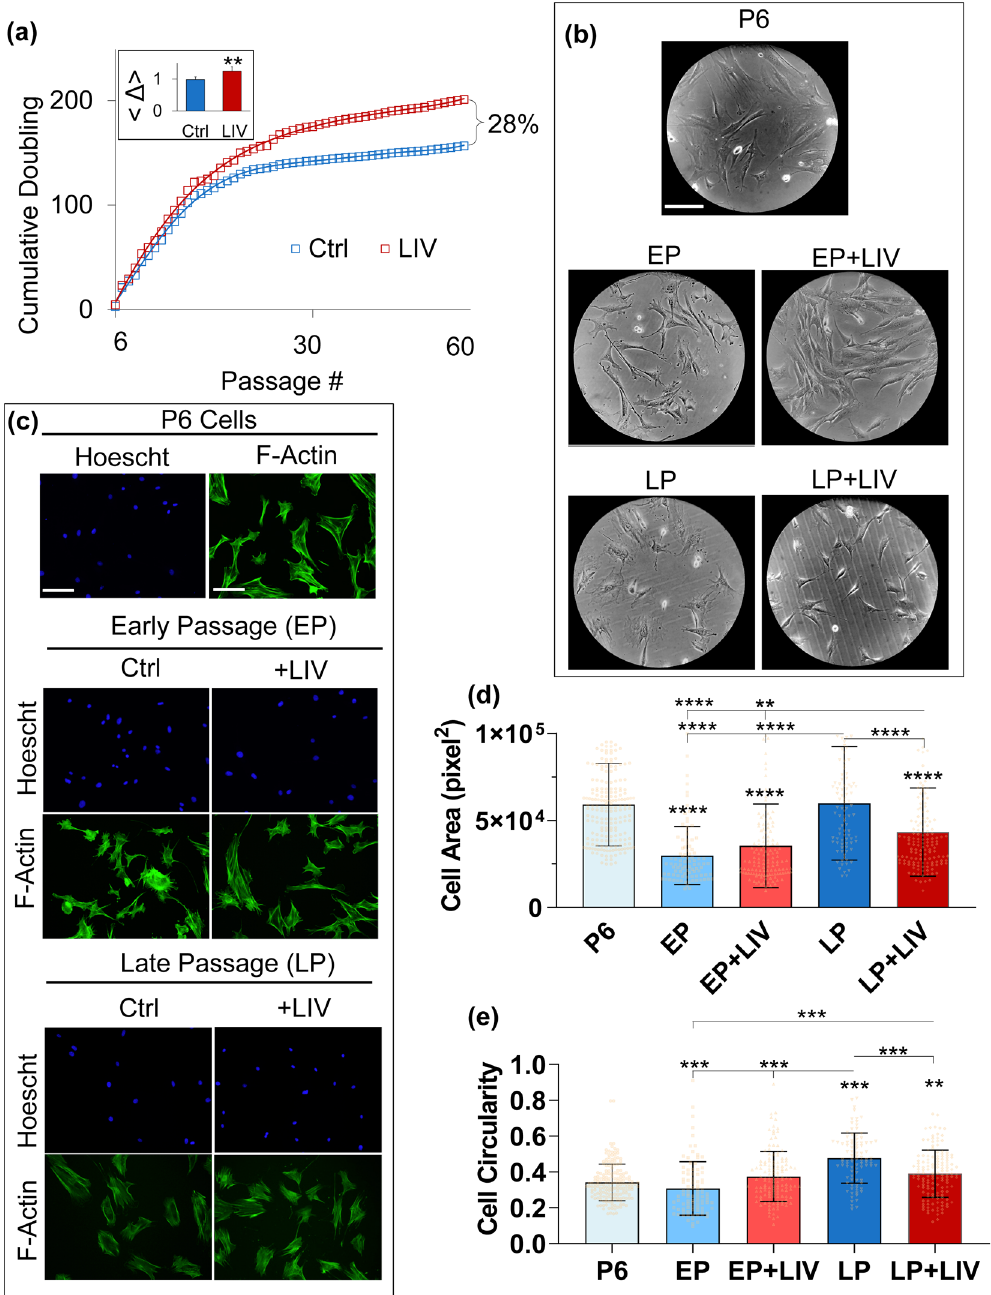
Figure 2. LIV increases proliferation and decreases cell size. ( a ) Long term-LIV resulted in a consistent improvement of proliferation over 30 + weeks, adding up to an 28% cumulative difference of cell doubling at passage 60 (P60). On average, + LIV group had a 27.7% (p < 0.01) increased cell doubling when compared to non-LIV control ( Δ , inset on top left). ( b ) Cell morphology at EP and LP time points showed that non-LIV controls exhibited a more circular while + LIV groups were more spindle like and elongated. ( c ) Fluorescent labeling of cell nuclei (Hoechst 33342) and F-actin (phalloidin) were performed to quantify cell and nuclear morphology. ( d ) Cell area of the P6 group was 5.90 × 104 px 2 , areas of the EP and EP + LIV groups were 2.97 × 104 px2 and 3.53 × 104 px 2 , showing 50% and 40% reduced cell area, respectively (p < 0.0001). The cell area of the LP group was 5.97 × 104 px2 and was not different than the P6 group. Cell area of the LP group remained 51% and 41% larger compared to both the EP and EP + LIV groups (p < 0.0001). Cell area of The LP + LIV group was 4.32 × 104 px 2 , a 27% and 28% decrease when compared to the P6 and LP groups, respectively (p < 0.0001). Cell area of The LP + LIV group also remained 32% (p < 0.0001) and 19% (p < 0.01) elevated when compared to the EP and EP + LIV groups, respectively. ( d ) Average circularity of P6 control was 0.34 where “1” represents a perfect circle and “0” represents a line. EP and EP + LIV showed no changes in cell circularity when compared to P6. Cell circularity of non-LIV LP controls was 0.47, a 38.2% increase when compared to the P6 group (p < 0.0001). Compared to LP, average cell circularity of LP + LIV group was